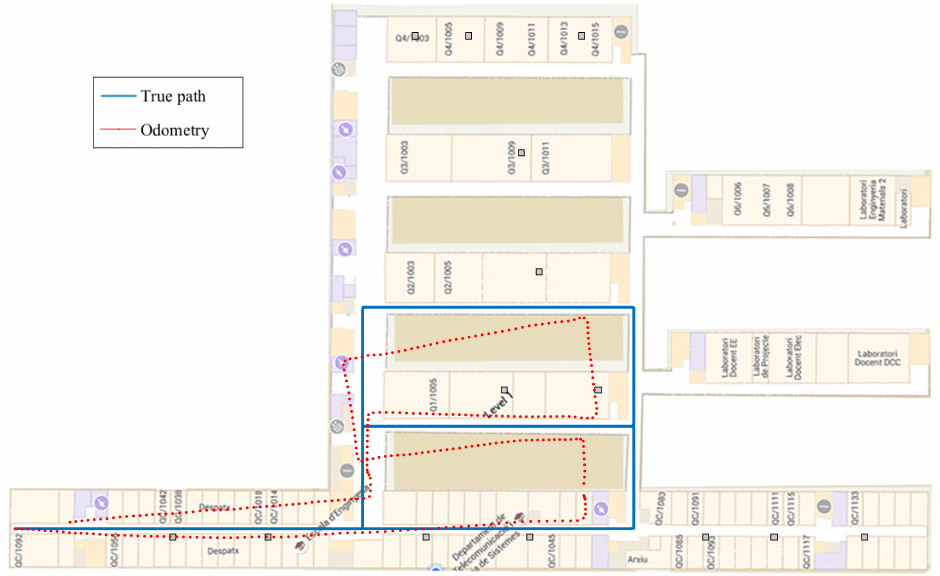
Figure 6. Path 2 and odometry obtained with the pocket navigation